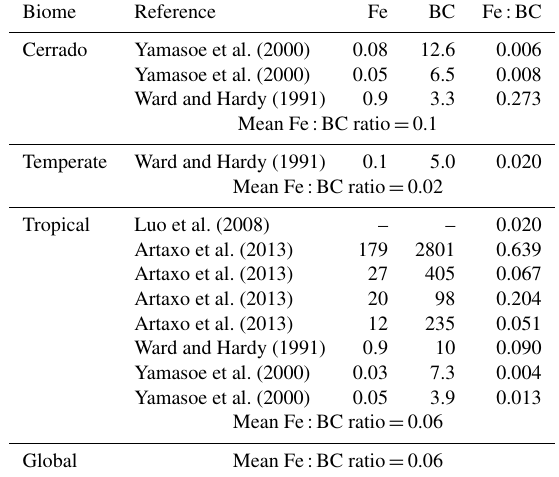
Table 4. Measured iron (Fe) and black carbon (BC) values (various units; as only the Fe:BC ratio is required they are not included) and the Fe:BC ratio; calculated with three decimal places, ratio re- ported to one significant figure to reflect high uncertainty. Modelled fire emission ratio for Fe:BC then calculated from observed